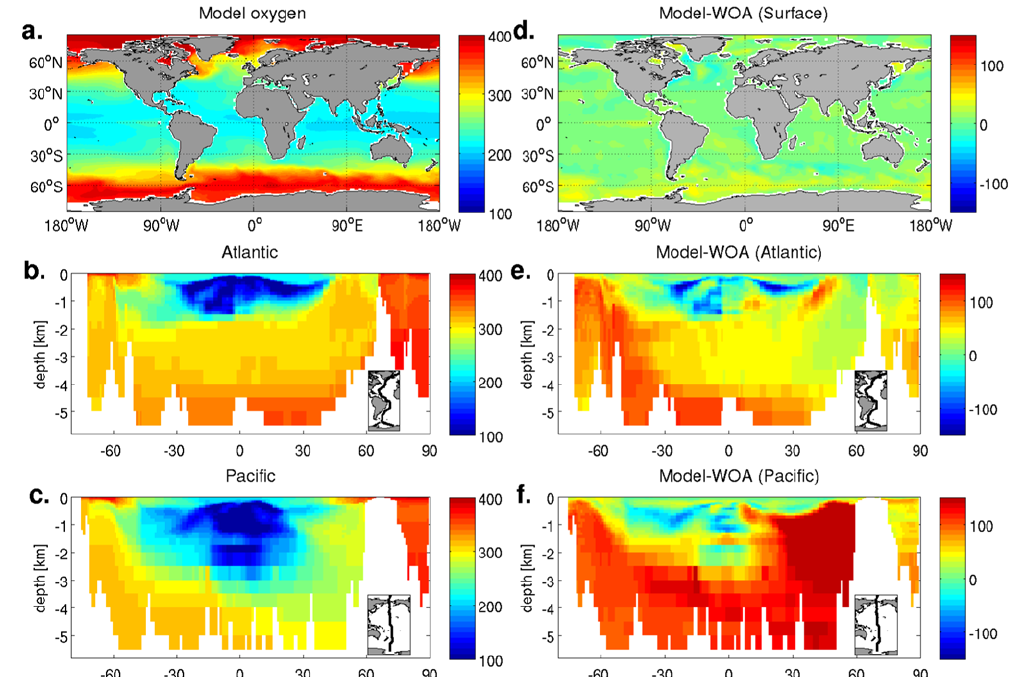
Fig. 7. Distribution of dissolved oxygen concentration from model simulation (left) and difference between the model and climatological estimates (right) (WOA, Garcia et al., 2010a) for the surface (a, d) , Atlantic (b, e) , and Pacific (c, f) vertical sections. Units are in (µmolL − 1